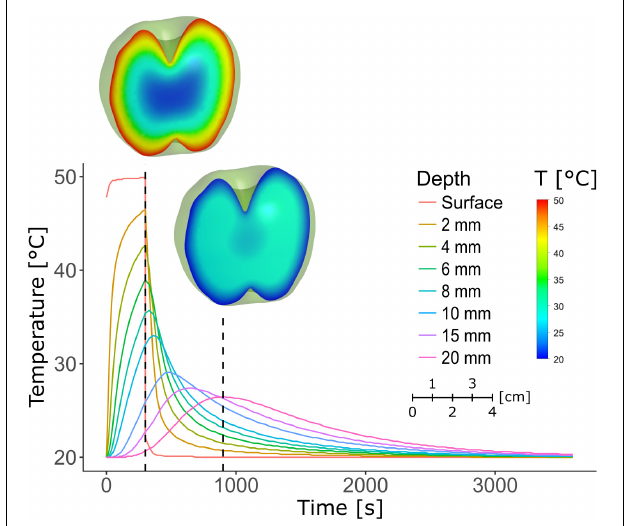
FIGURE 9 | Simulation of the temperature profile in an apple as a function of time during and after a 50 ◦ C HWD of 5 min. The first dashed line marks the end of the 5 min treatment, the second marks 15 or 10 min of air cooling after the treatment. Fruit heatmaps corresponding to the dashed lines show the temperature profile in the fruit at those time